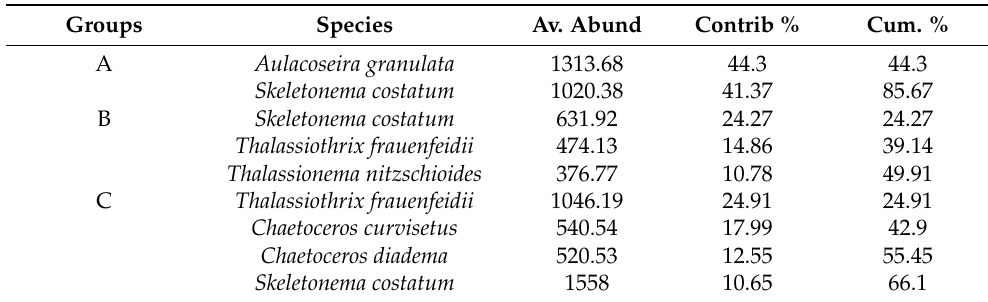
Table 5. Similarity analysis of the phytoplankton community composition in the waters around Macau examined in December 2019.